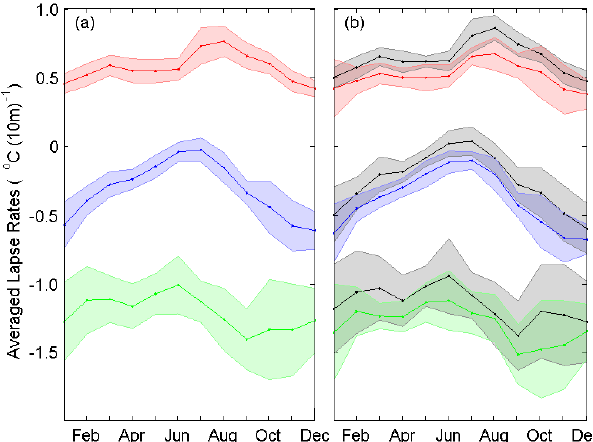
Figure 4. (a) Lapse rate seasonality averaged over 1997 to 2013 for daily (blue), daytime (red), and nighttime (green) periods; standard deviations are represented by shaded areas. The significant trends in daily, daytime, and nighttime lapse rates (Fig. 3b, c and d) were removed before calculating the standard deviation. (b) The same as (a) but averaged over the first 10years (1997–2006; gray areas with black lines) and averaged over the last 10years (2004–2013; blue for daily, red for daytime, and green for